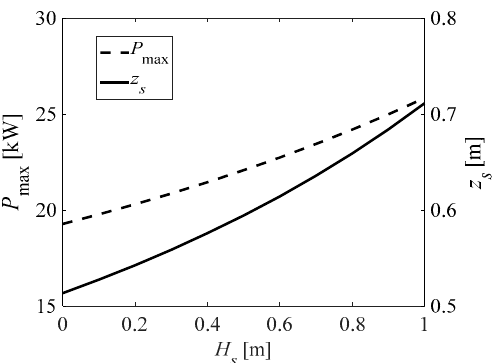
Figure 6. An example of the maximum absorbed power P max and significant motion amplitude z s as functions of the buoy mass ratio m n at the sea state of T e = 8 s and H s = 2 m for a vertical truncated cylindrical buoy with the radius-to-draft ratio of r / d = 1.